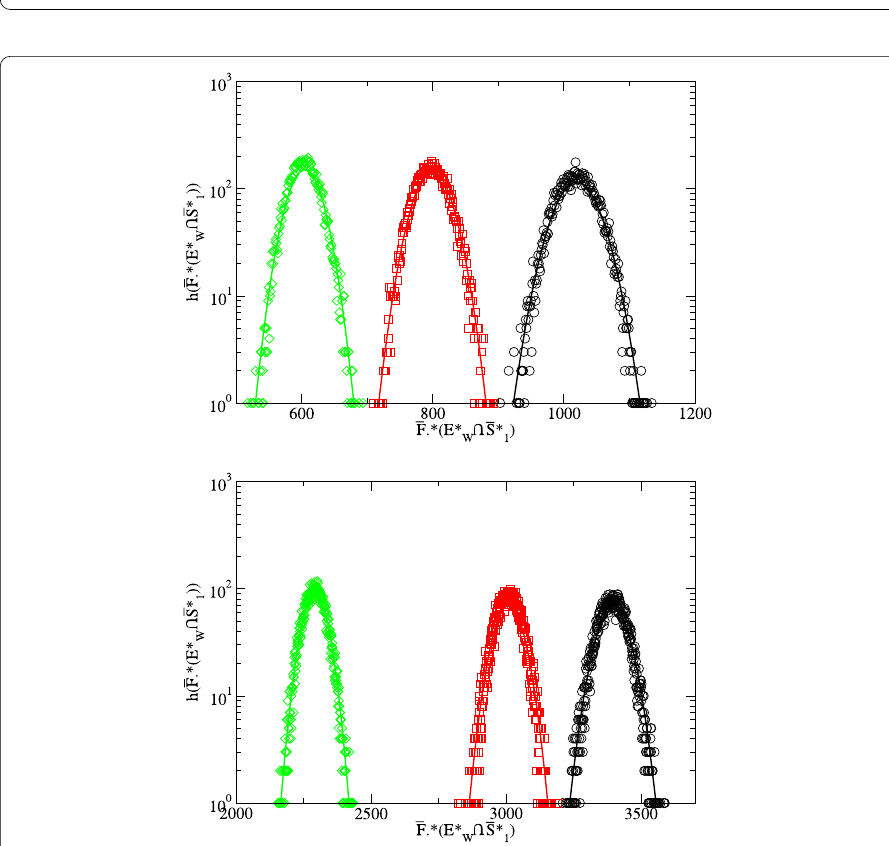
Figure 13 Histograms h ( ¯ F ∗ ··· ( E ∗ W ∩ ¯ S ∗ 1 )) from simulations (symbols) and their least square fits (lines) with W = 1 (black ◦ ), 2 (red (cid:3) ), 3 (green ♦ ) for years t = 1992 (top) and t = 2000 (bottom). All histograms have been constructed from M = 10 4 Monte Carlo realizations